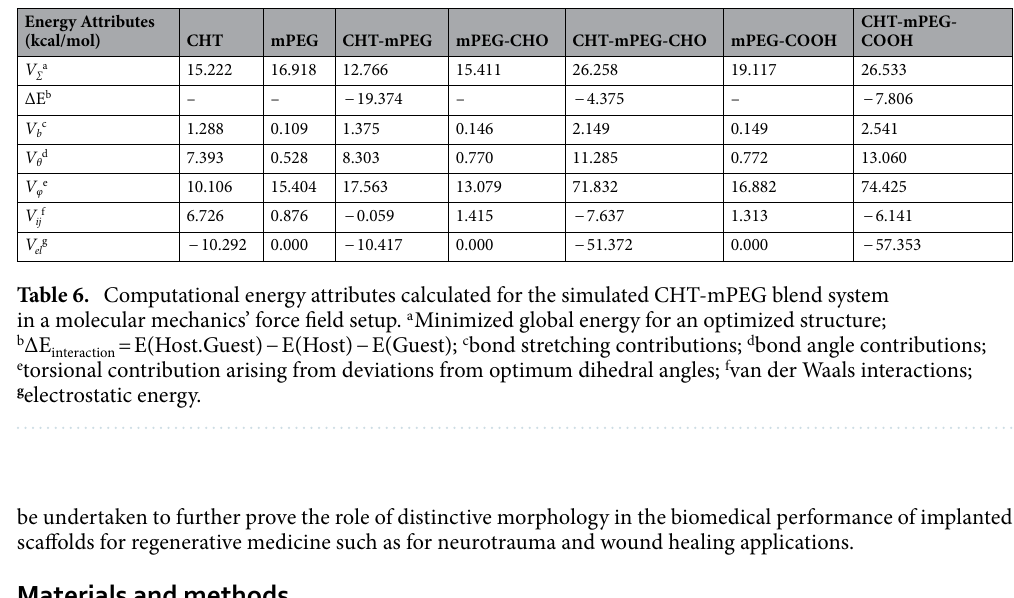
Figure 11. Visualization of geometrical preferences of ( a ) CHT-mPEG; ( b ) CHT-mPEG-CHO; and ( c ) CHT- mPEG-COOH molecular complexes after molecular simulation in vacuum (Color codes: C (cyan), O (red), N (blue) and H (white)) and 3D-mapped isosurface plot representing the electrostatic potential for ( d ) CHT- mPEG; ( e ) CHT-mPEG-CHO; and ( f ) CHT-mPEG-COOH molecular complexes.